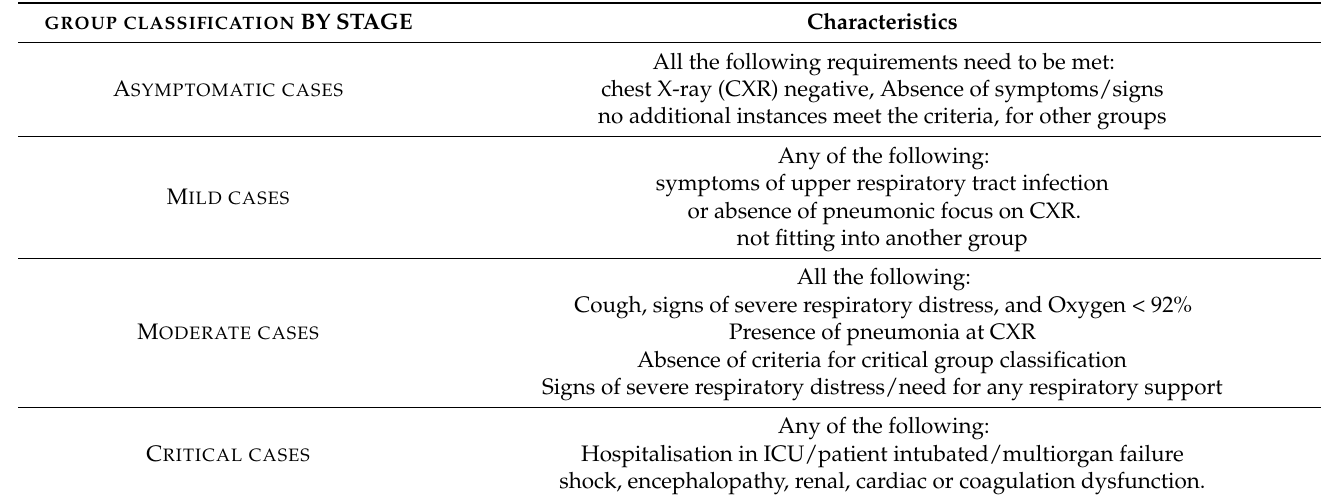
Table 1. Group classification based on characteristics described by Parri and adapted by Dong et al. [31–33]. GROUP CLASSIFICATION BY STAGE Characteristics A SYMPTOMATIC